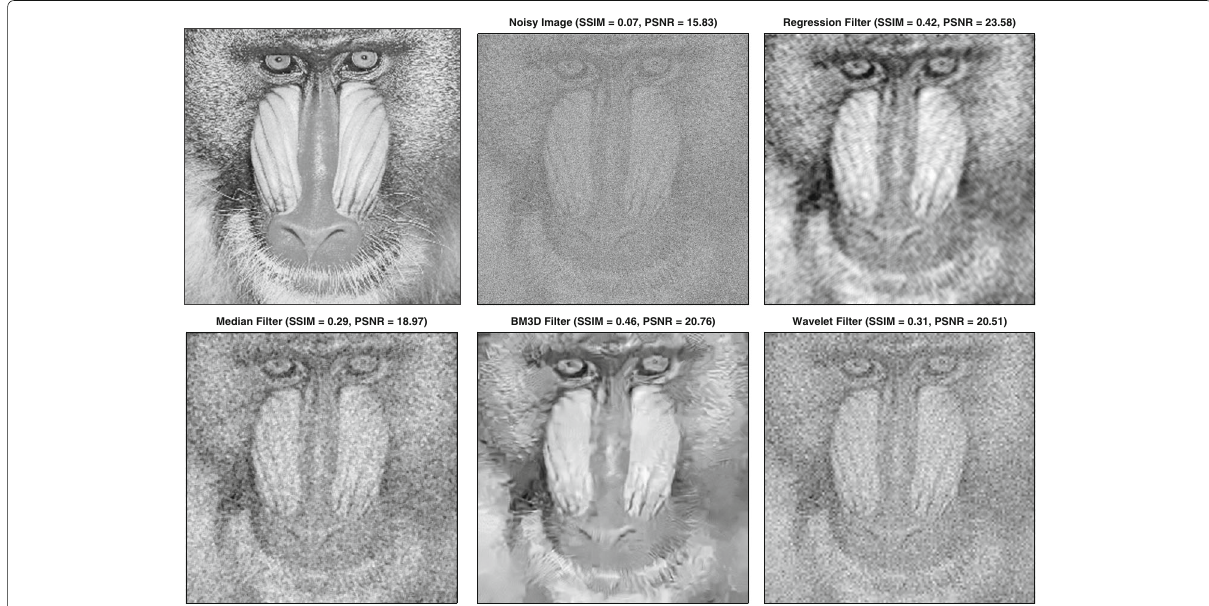
Fig. 9 Applied Poisson and added Gaussian noise with σ = 100. From left to right: a clean mandril, b noisy image, c denoised image using our L 2 regression filter, d denoised image using median filter, e denoised image using BM3D, and f denoised image using wavelet filter